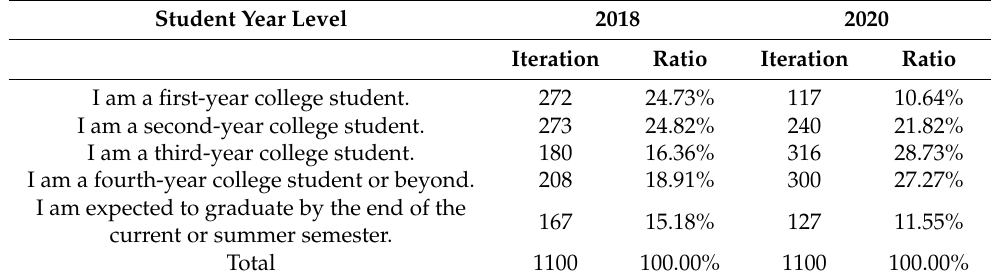
Table 1. Distribution of student numbers by student year level between 2018 and 2020 survey